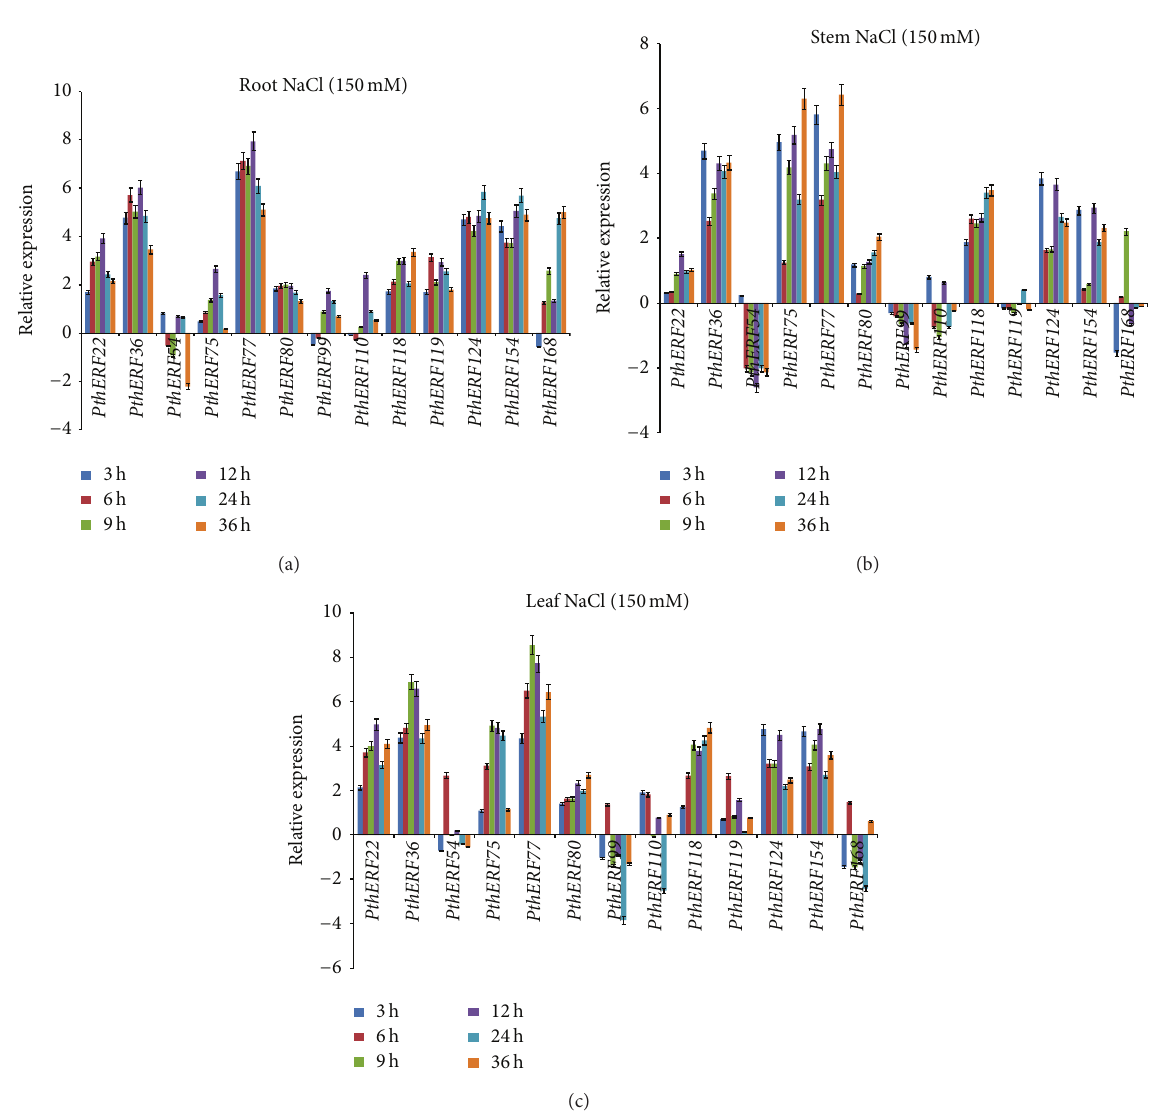
time points, PthERF54 and PthERF99 were significantly downregulated or were similar to the controls. PthERF110 was upregulated by ABA treatment at 6 h and 12 h. The highest expression levels of the remaining ten PthERFs occurred at 12 h, and these genes were significantly induced or did not differ significantly from the controls during the entire treatment time (Figure